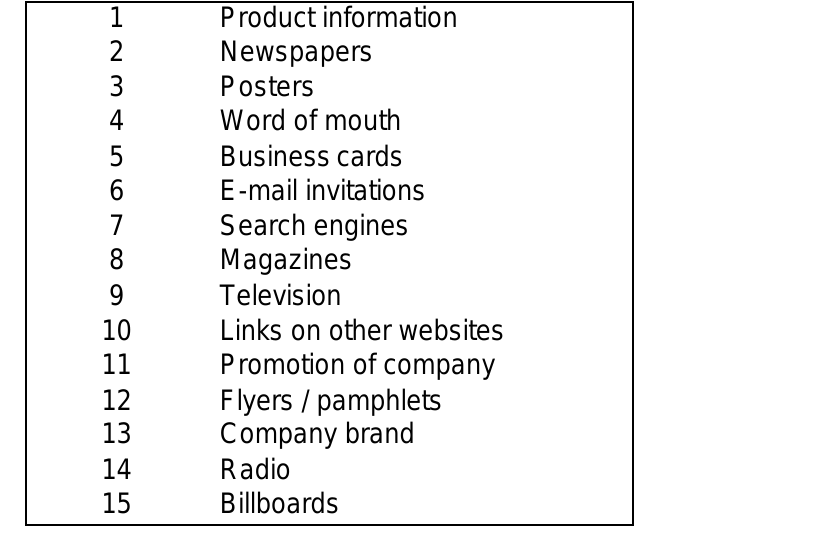
TABLE 4: IMPORTANCE OF VARIABLES TO INFLUENCE RESPONDENTS TO VISIT WEB